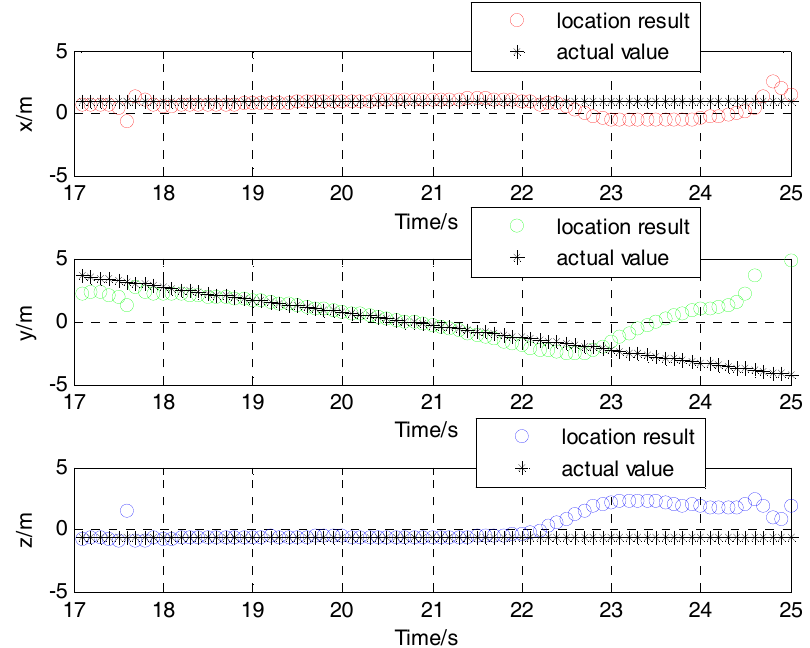
Figure 19. Contrast of location result and actual value in three directions of the experimental tests. The location results of rotation angle for the ferromagnetic target are shown in Figure 20a. In order to verify the accuracy of the angular rotation between the three-component magnetic moments of the magnetic dipole and the three axes of the magnetic sensor array, we have used these angular data to calibrate the magnetic field data of three noncollinear fluxgate sensors in three direction. As shown in Figure 20b–d, the three-component magnetic field signed B 2 x , B 2 y and B 2 z calibrated by angular data signed α 1 , α 2 and α 3 have a good agreement with the magnetic field signed B 0 x , B 0 y and B 0 z of the ferromagnetic target without angular rotation. As well, the magnetic field signed B 0 x , B 0 y and B 0 z was measured by the magnetic sensor array under the same experimental condition without deliberate angular rotation. The three-component magnetic field signed B 2 x , B 2 y and B 2 z calibrated by angular data signed α 1 , α 2 and α 3 all have a peak around the time of 22 s in Figure 20b–d. There may be the interference of magnetic noise and clutter in the measurement